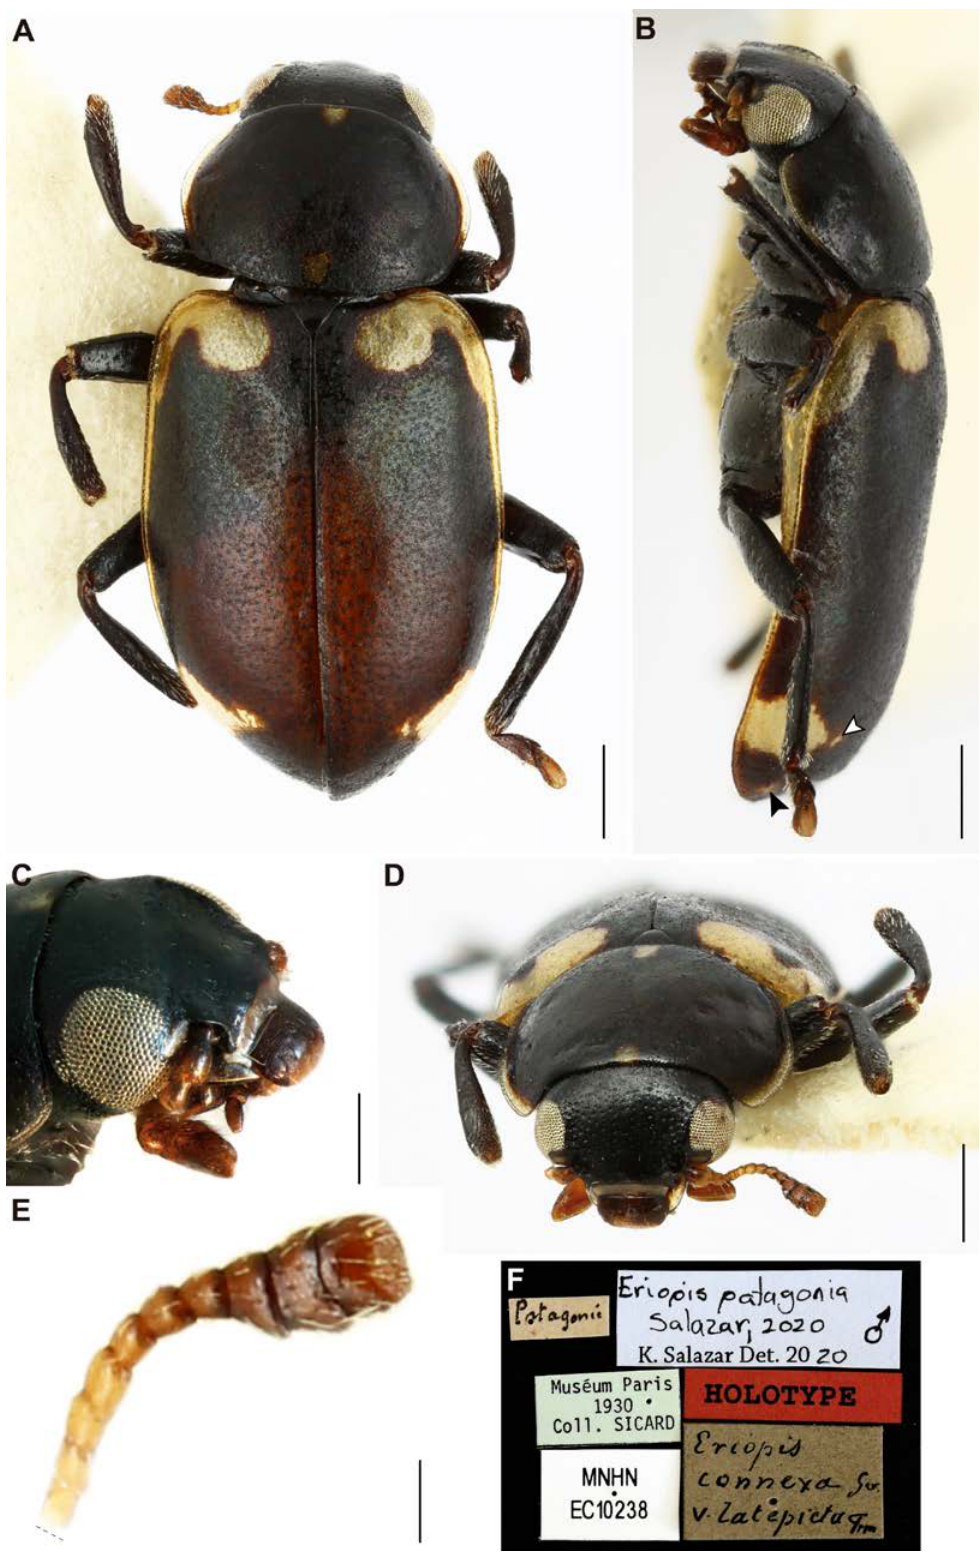
Figure 1. Eriopis patagonia Salazar, sp. nov. — Holotype: dorsal ( A ), lateral ( B , C ) and frontal ( D ) views. ( B ). The arrowheads signaled the tiny additional spots, which are not present in the Paratype. ( E ). Antenna with 10 antennomeres (without the basal scape). ( F ). Labels. Photographs of the specimen were made after DNA extraction. Scale bars (mm): ( A – D ) 0.5; ( E ) 0.12.